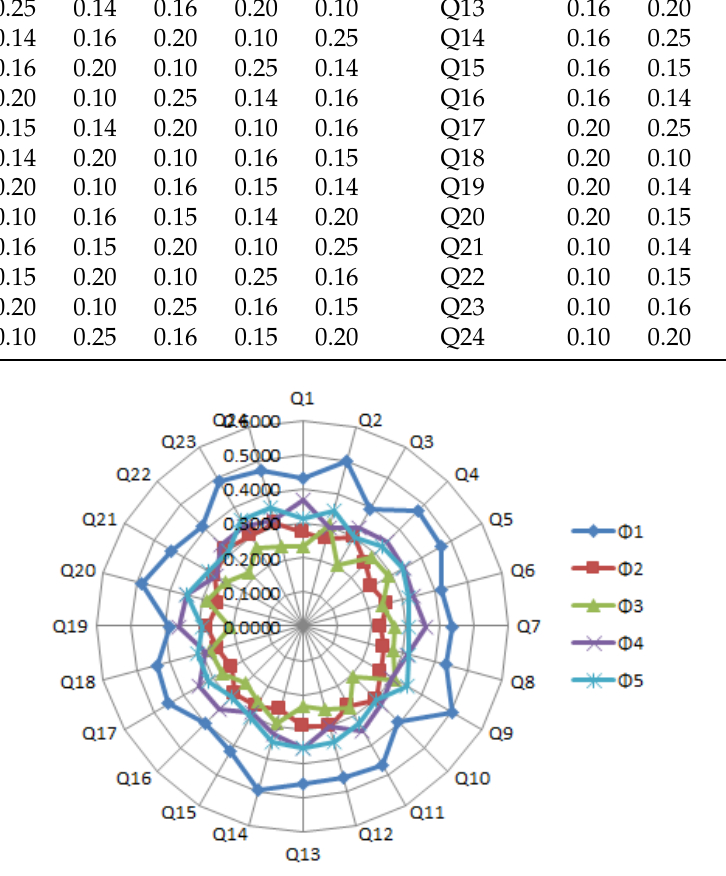
Figure 3. Utility values of alternatives for distinct sets of weighted criteria. Table 5. Priority order of alternatives for diverse weight